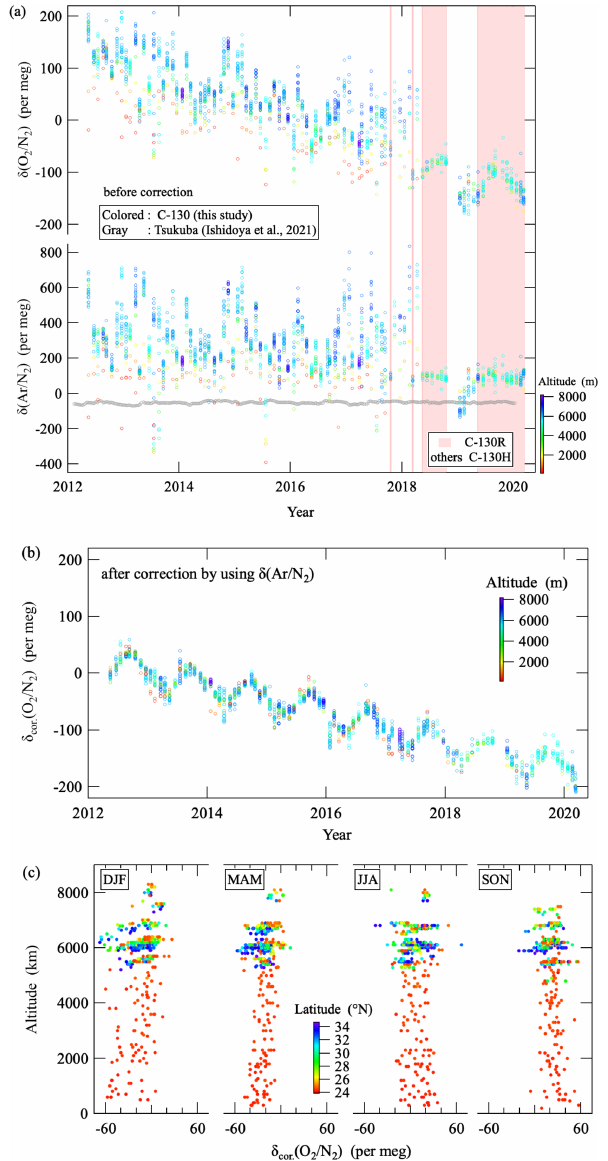
Figure 3. (a) Measured values of δ (O 2 / N 2 ) and δ (Ar / N 2 ) for all the air samples collected on board the C-130 aircraft. δ (Ar / N 2 ) values observed at Tsukuba, Japan, are also shown as gray circles (Ishidoya et al., 2021). Shaded areas denote the periods when C- 130R aircraft was used, and C-130H aircraft was used in other pe- riods. The color bar indicates the altitude where the air sampling was carried out. (b) δ cor . (O 2 / N 2 ) corrected for artificial fraction- ation by applying Eq. (6) (see text). The color bar indicates the al- titude where the air sampling was carried out. (c) Vertical profiles of detrended δ cor . (O 2 / N 2 ) separated by season (DJF: December to February, MAM: March to May, JJA: June to August, and SON: September to November), obtained by subtracting a linear secular trend, fitted to the δ cor . (O 2 / N 2 ) in (b) , from each δ cor . (O 2 / N 2 ) value. The color bar indicates the latitude where the air sampling was carried